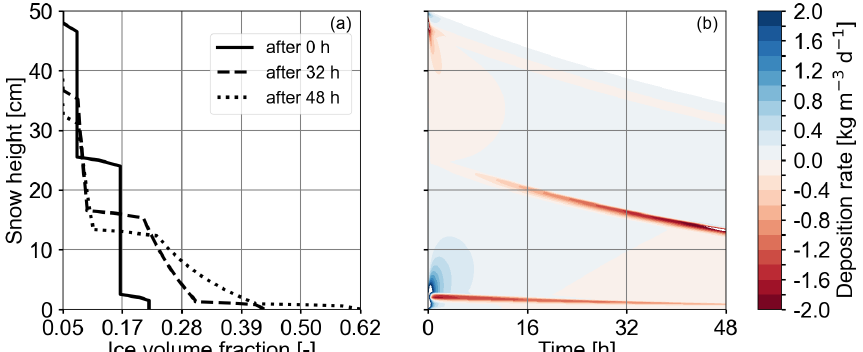
Figure 13. The simulations were carried out based on Case 5 of Table 2, which is the fully coupled processes with constant viscosity. Panel (a) shows the profiles for the ice volume fraction ( x axis) over snow height ( y axis) for a test case that has a thin layer at the top and bottom of the snowpack. The line corresponding to 0h shows the initial condition for the ice volume fraction. The thin layers at the top and bottom each have a thickness of 2cm. Panel (b) depicts the evolution of the deposition rate. The three transition areas of the four layers are characterized by increased sublimation rates (after 16h at snow heights 42, 20 and 2cm). The lobes at the top and bottom at the start of the simulation are due to the strong phase change activity triggered by the initial and boundary